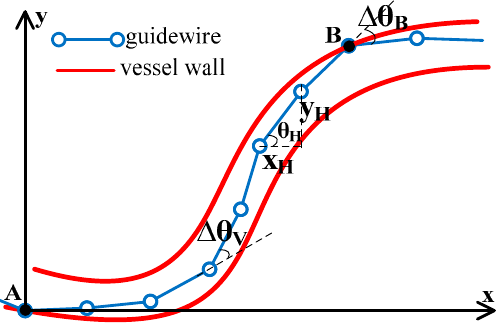
Figure 2. The discrete model of the guidewire.